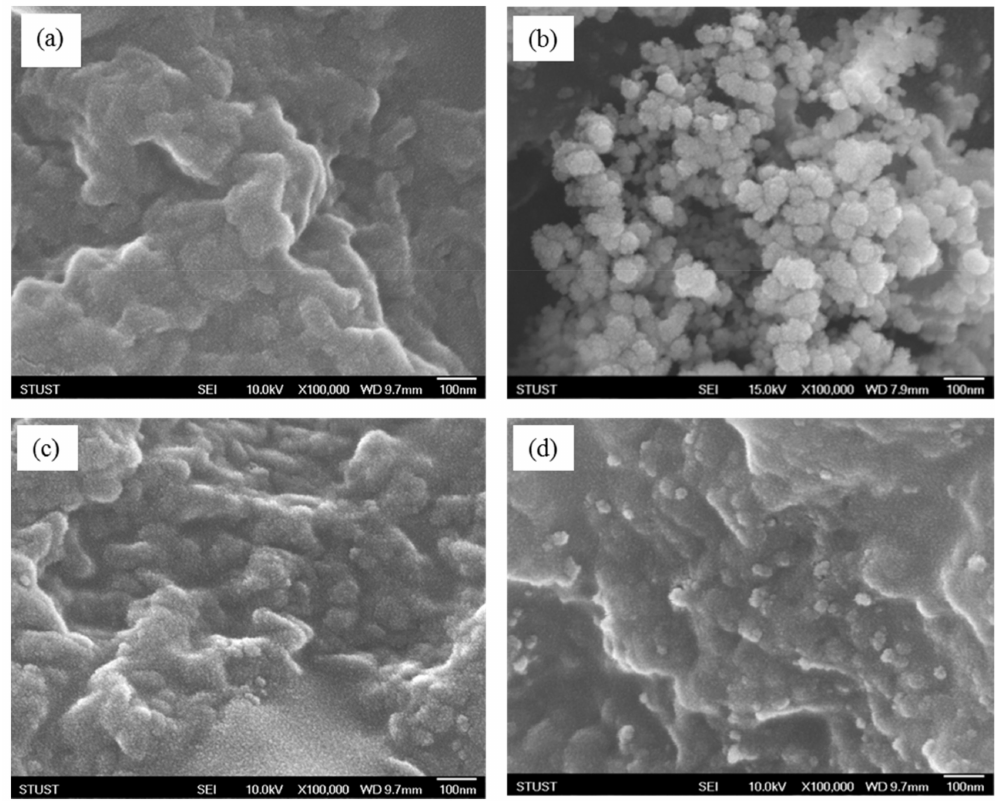
Figure 6. FE-SEM images of ( a ) pure PANDB, ( b ) γ -Al 2 O 3 , and conductive PANDB/ γ -Al 2 O 3 core– shell nanocomposites synthesized at weight ratios of AN/ γ -Al 2 O 3 = ( c ) 3/1 and ( d )